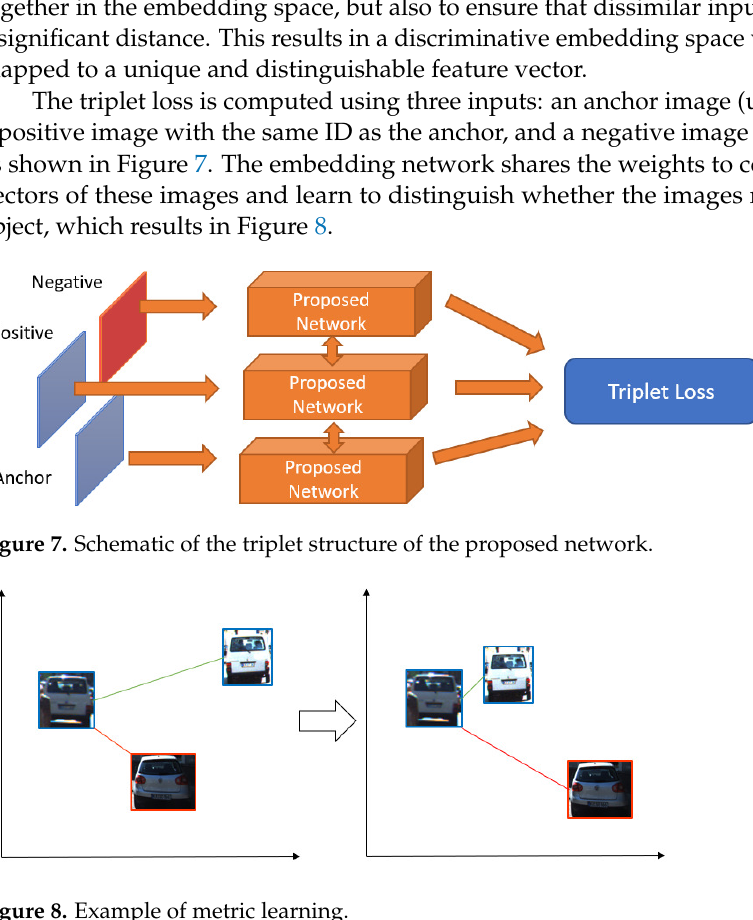
Figure 8. Example of metric